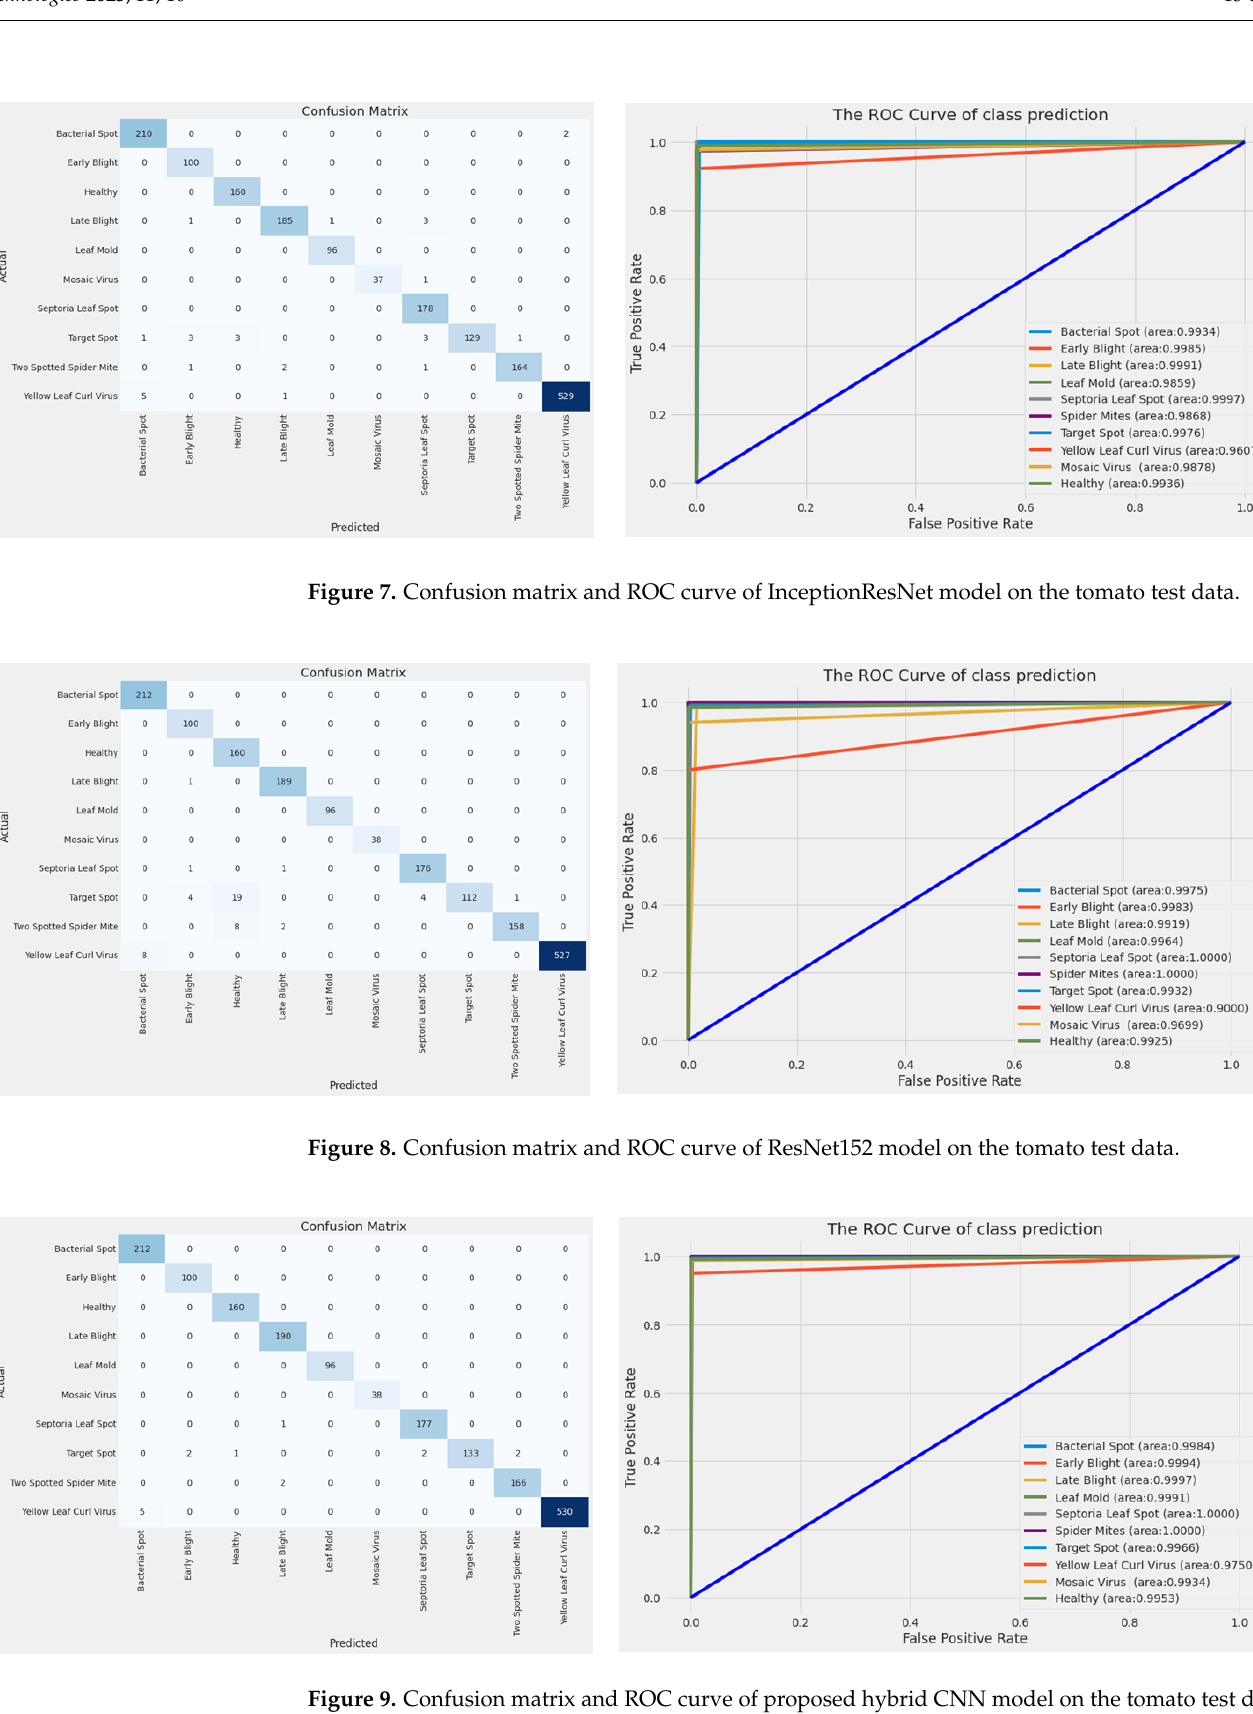
Figure 9. Confusion matrix and ROC curve of proposed hybrid CNN model on the tomato test